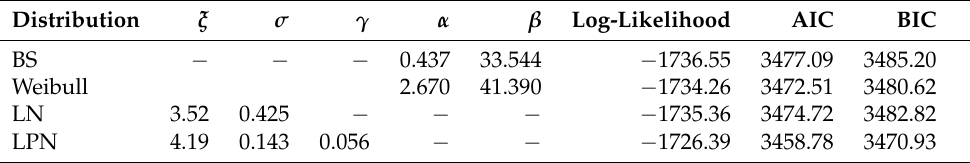
Table 12. Maximum likelihood estimates using cement concrete strength data